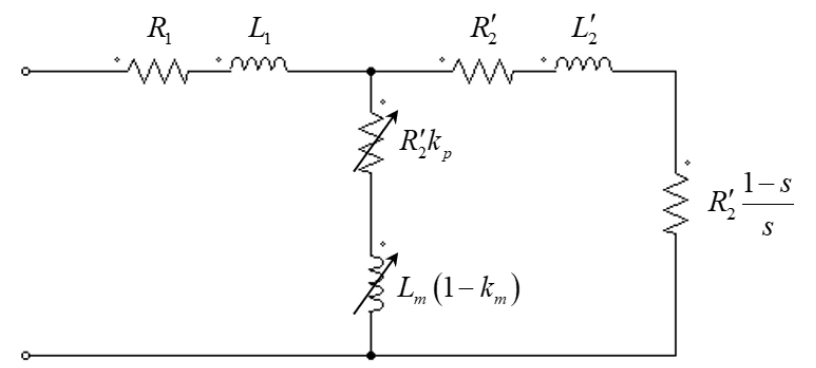
Figure 6. New proposed equivalent circuit considering all secondary leakage